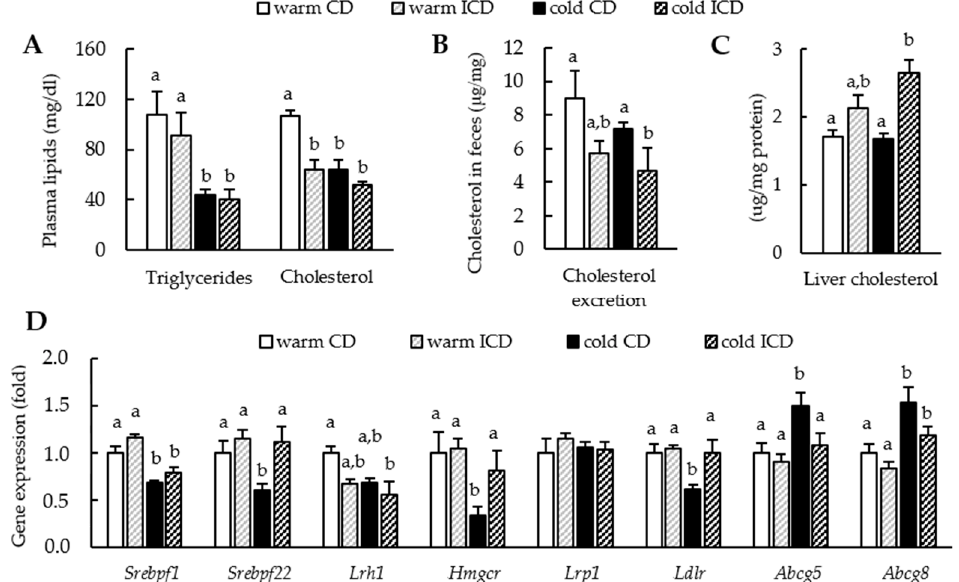
Figure 3. Inulin supplementation alters cholesterol handling. ( A ) Plasma lipids; ( B ) cholesterol levels in feces; ( C ) liver cholesterol levels and ( D ) relative expression of genes related to cholesterol metabolism normalized to Tbp as the housekeeper in livers. Data are shown as mean values ± SEM, and different letters indicate significant differences between groups ( p < 0.05) determined by two-way ANOVA. CD warm: n = 6; ICD warm: n = 6; CD cold: n = 6; ICD cold: n = 5 (ICD cold plasma lipids n = 4).